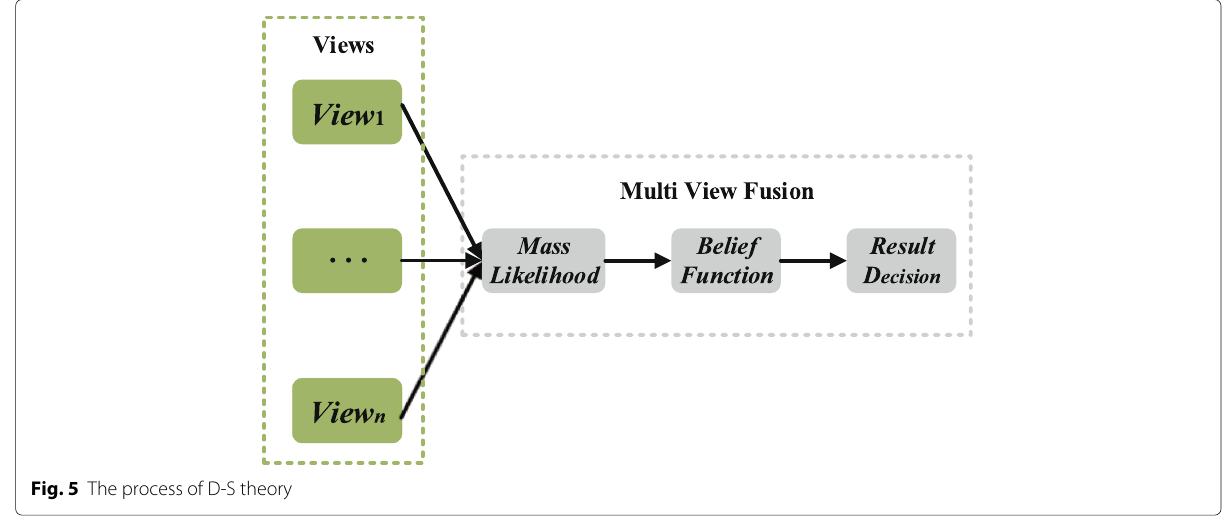
Fig. 5 The process of D-S